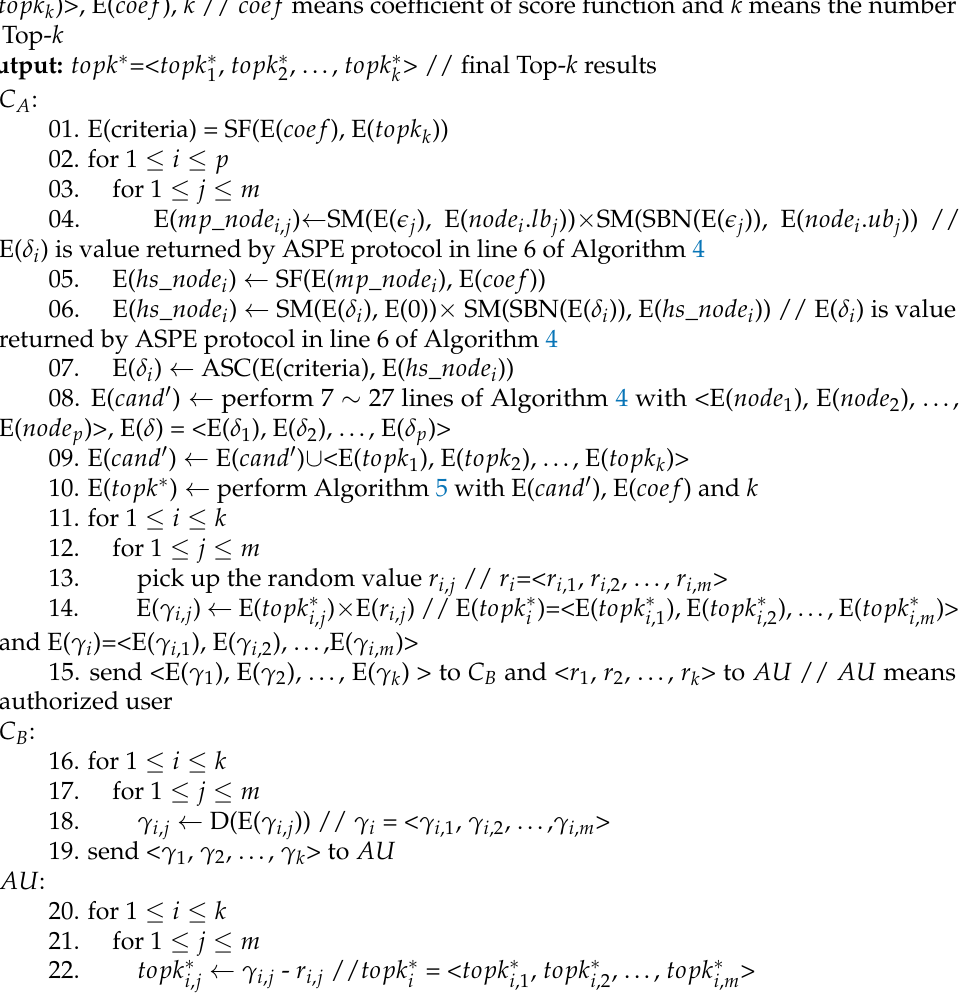
Algorithm 6 Top- k result refinement